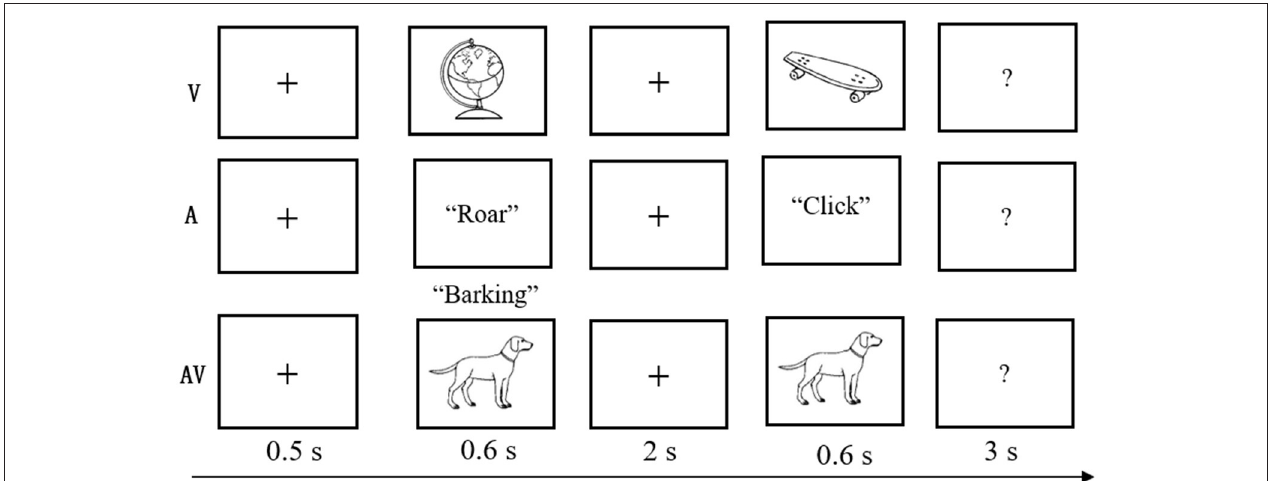
FIGURE 1 | Schematic of the experimental task. A three-block design was used in the behavioral experiment. In each three-block trial, a fixation cross was shown for 0.5s; a stimulus (visual-V, auditory-A, or congruent audiovisual-AV) was then presented for 0.6s; a blank screen was shown for 2s; and finally, the test stimulus appeared for 0.6s with a 3-s time